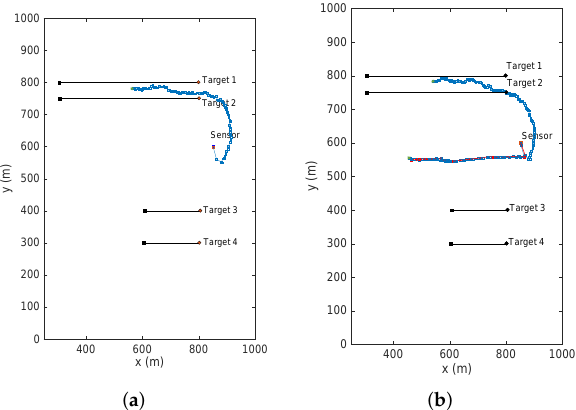
Figure 12. Sensor trajectories with non-selective (PEECS) and selective sensor control methods as reported in [16]: ( a ) comparison of the resulting sensor trajectories using PEECS [26] and selective-PEECS. [16], ( b ) sensor trajectory using maximum confidence method for sensor control solution [16].